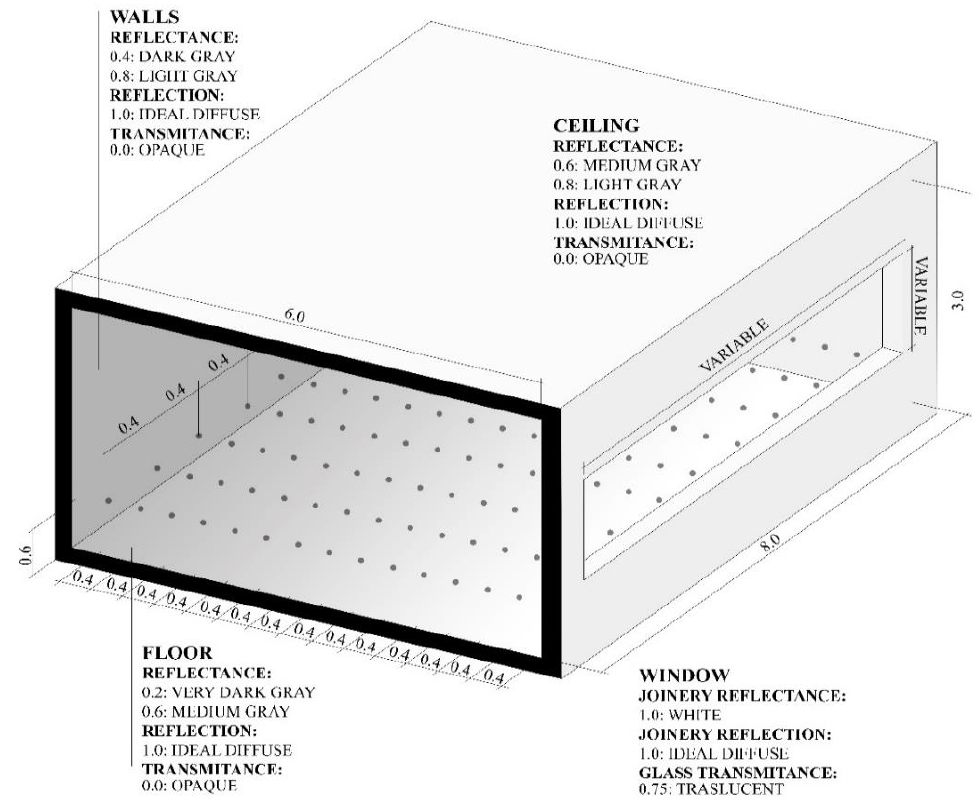
Figure 3. Characteristics of the room model.